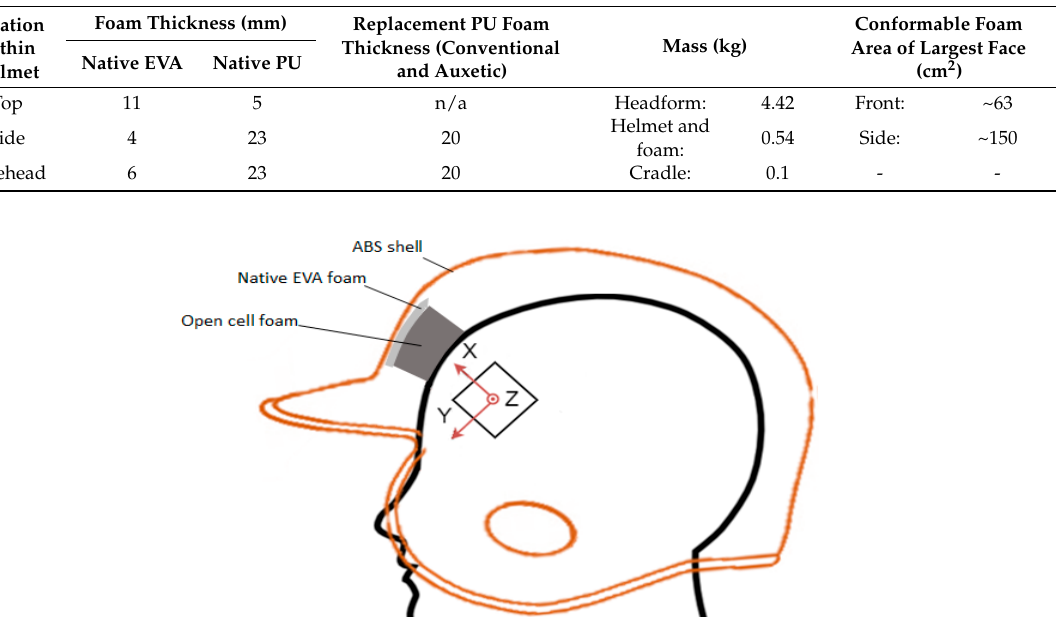
Table 1. Helmet and foam properties.